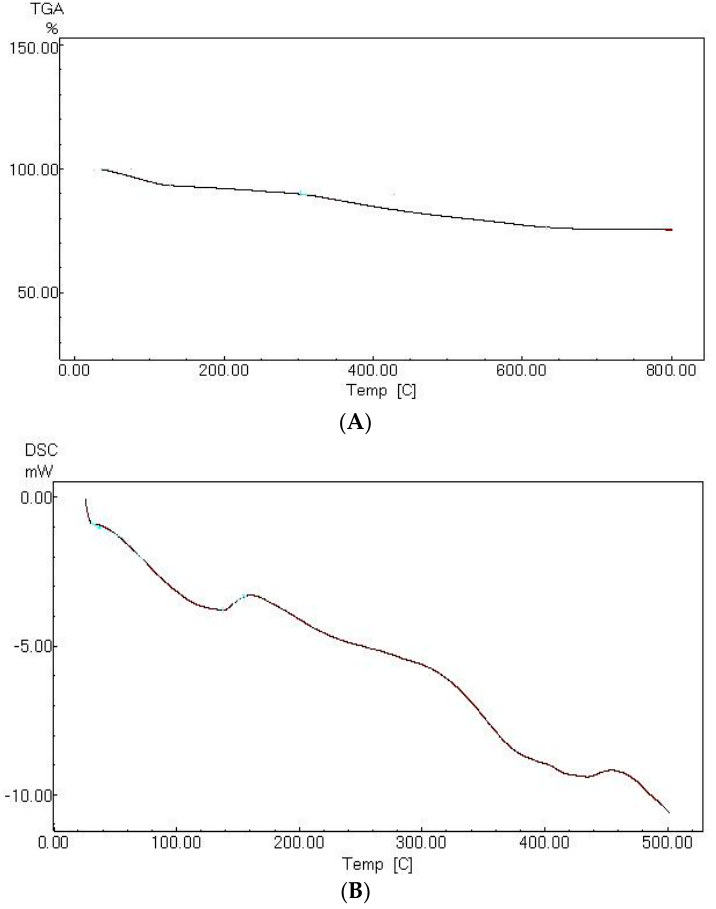
Figure 8. Thermal profile of magnetic amine-functionalized silica gel (MANSG): ( A ) TGA; ( B ) DSC.